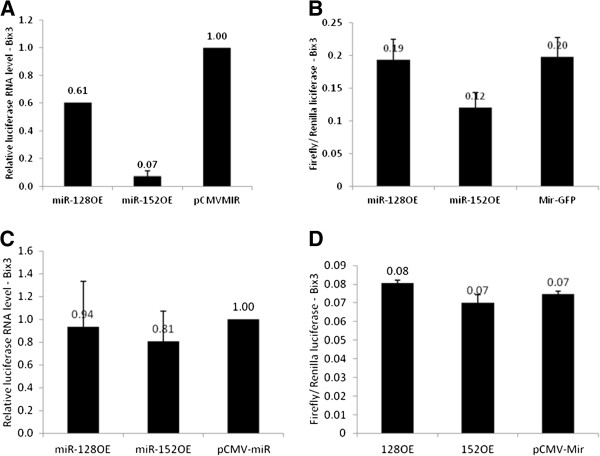
Target-A is an active target for miR-128 and miR-152. Either miR-128 or miR-152 was overexpressed together with either A, B) wild type construct (Luc-CSF-1 3’UTR-Wt) or C, D) Target-A mutant construct (Luc-CSF-1 3’UTR-Mut) in Bix3 cells. Bars represent mean ± SD from triplicate experiments.